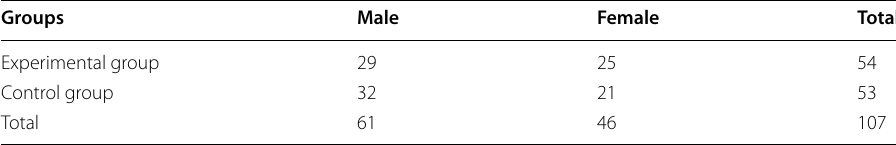
Table 1 Demographic characteristics of the participants